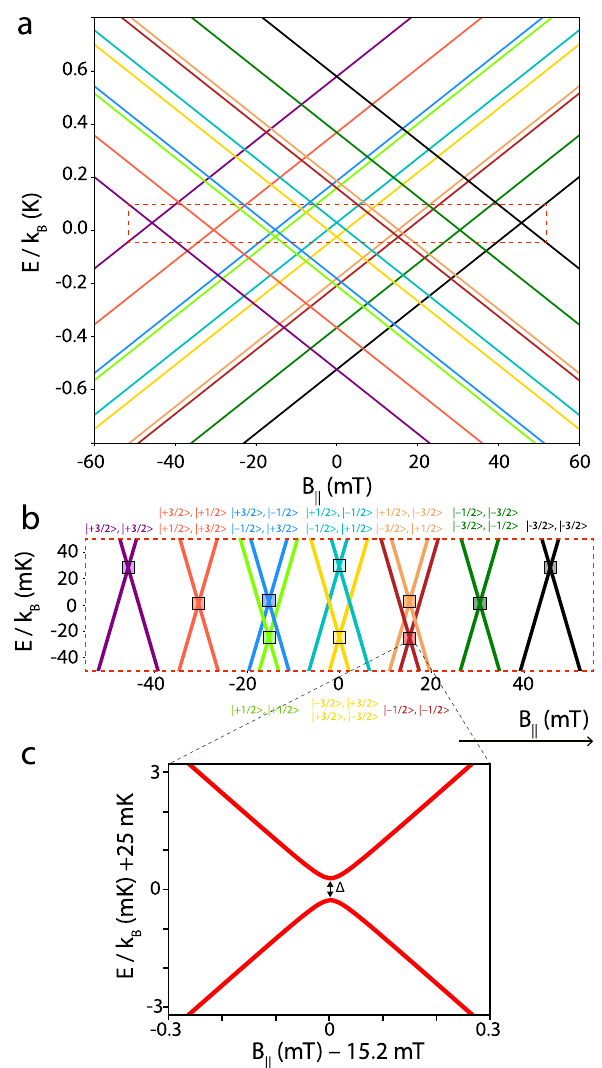
Fig. 2 Zeeman diagram of the ground ferromagnetic state of Tb 2 Pc 3 . a Tb 2 Pc 3 Zeeman diagram, considering all interactions. The ten colours are associated with the sixteen coupled nuclear spin states. Note that some of the events are degenerated. b Enlargement highlighting the ten anti- crossings, where the electronic spins reverse simultaneously. For each of the ten anti-crossings, the electronic spins have a Landau – Zener probability P to reverse from a jþ 6 ; þ 6 i state to a j(cid:4) 6 ; (cid:4) 6 ; i state. c Enlargement of one of the anti-crossings, with an anti-crossing energy Δ the histogram with a high amplitude and roughly equally spaced, (ii) peaks in the histogram with a smaller amplitude and width and unequally spaced from the previous ones. (i) We fi rst focus on the main feature corresponding to the peaks in the histogram with a high amplitude and relatively large width (counts framed in grey in Fig. 3c). Seven peaks are observed, corresponding to the ten anti-crossings where tunnel- ling is allowed as expected from the theoretical predictions. Note here that the experimental values do not correspond to the QTM positions expected from Eq. (6); consequence of the miss- alignment of the easy axis of the Tb 2 Pc 3 molecule with our applied magnetic fi eld. As a result, while the positions of the QTM in a parallel magnetic fi eld are expected within B k = ±46 mT, the measured positions using an external magnetic fi eld occur within B X = ±55 mT.